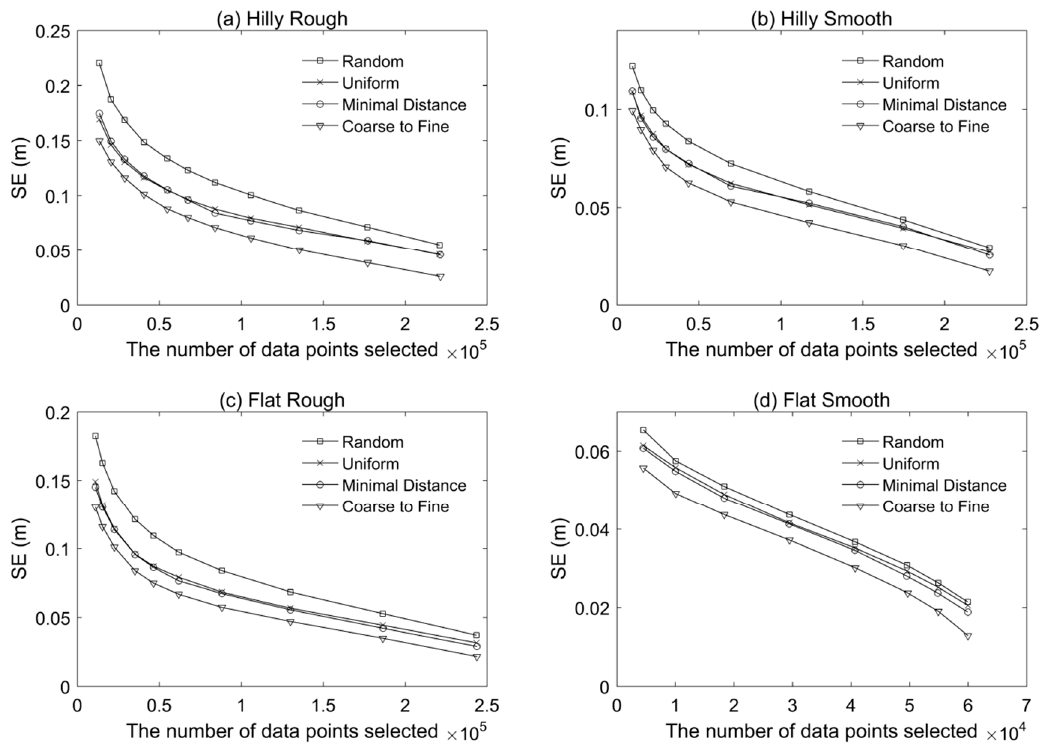
Figure 6. The magnitude of mean error (ME) versus the number of data points of thinned point clouds for the four terrain surfaces: ( a ) hilly rough, ( b ) hilly smooth, ( c ) flat rough, and ( d ) flat smooth.